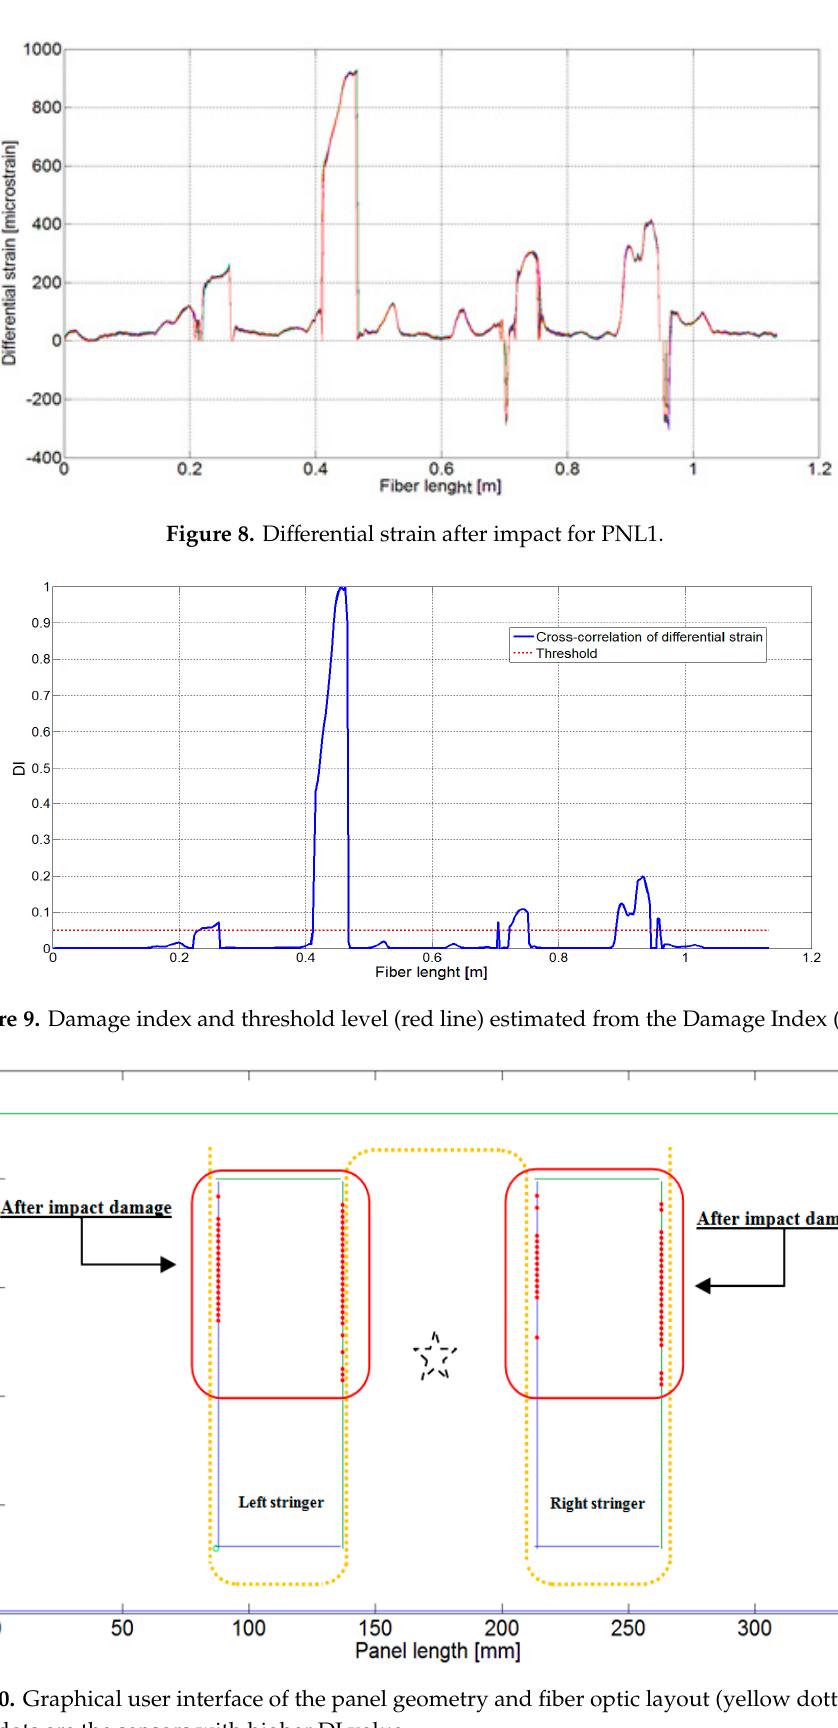
Figure 10. Graphical user interface of the panel geometry and fiber optic layout (yellow dotted line). The red dots are the sensors with higher DI value.